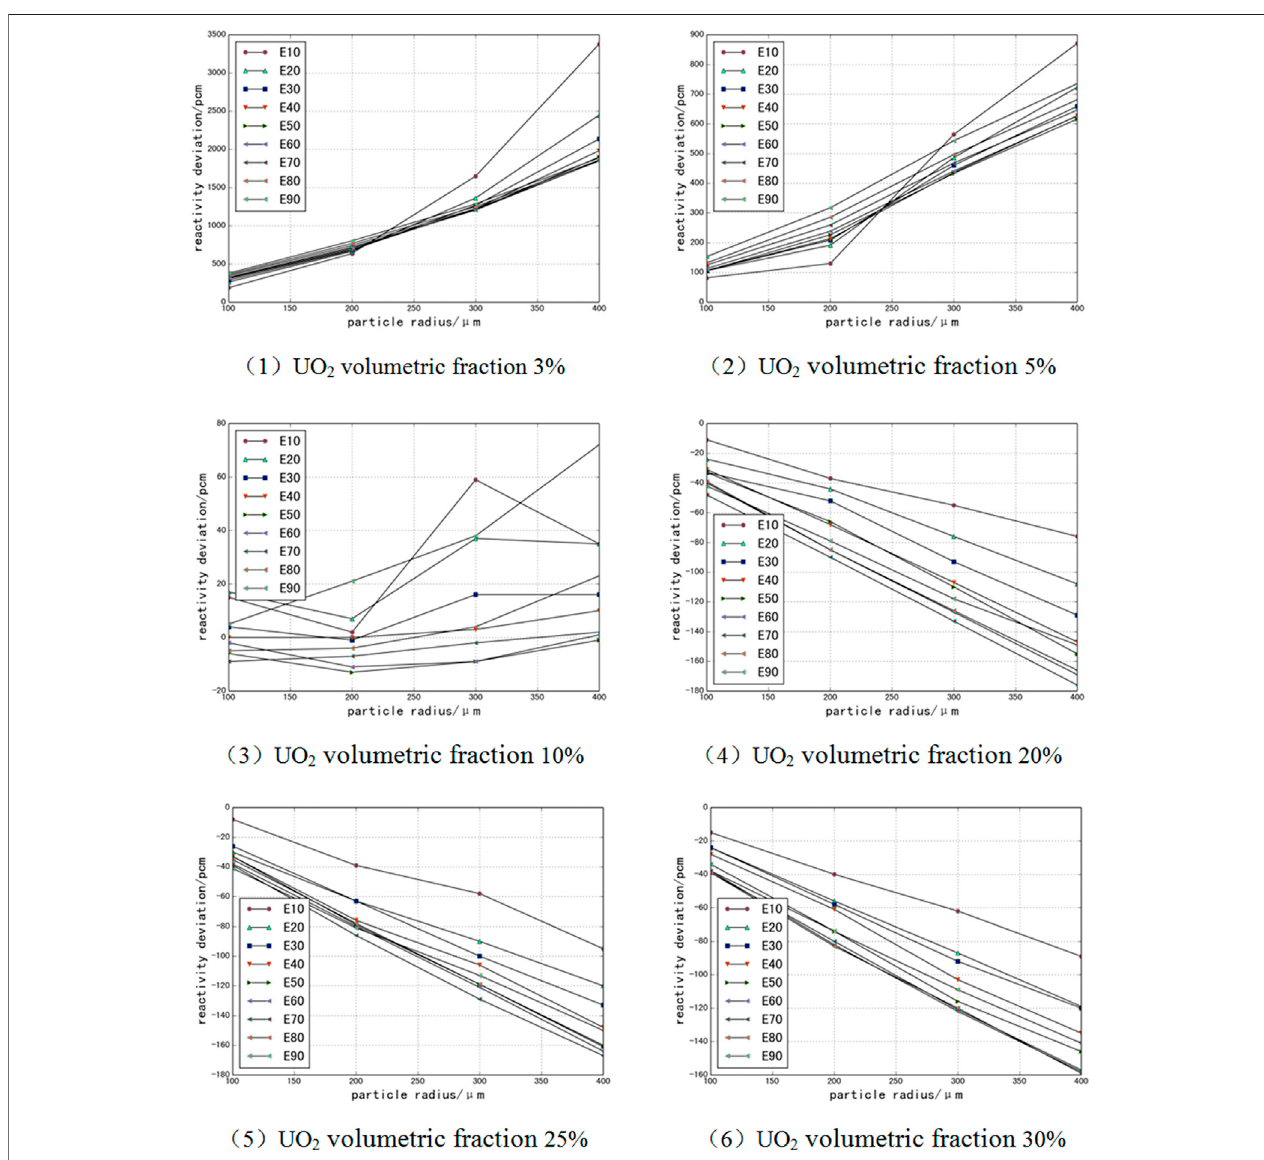
FIGURE 2 | Reactivity calculation deviation curve of different UO 2 volumetric